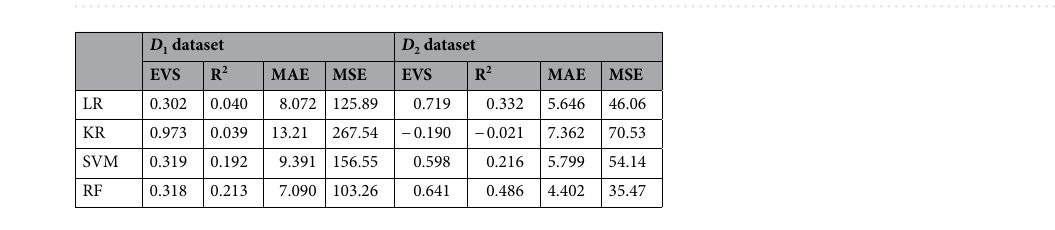
Table 1. Evaluation of the regression algorithms with the metrics.